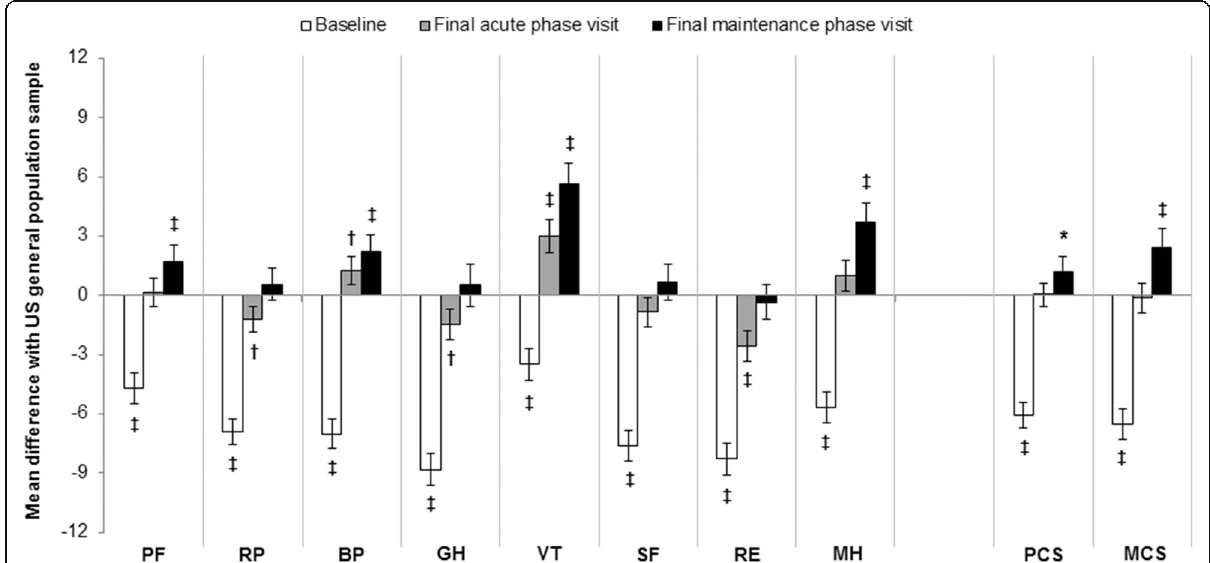
Fig. 2 SF-12v2 score differences between trial patients and an age- and gender-matched US general population sample. PF: physical functioning; RP: role physical; BP: bodily pain; GH: general health; VT: vitality; SF: social functioning; RE: role emotional; MH: mental health; PCS: physical component summary; MCS: mental component summary. Error bars reflect 95% confidence intervals around mean differences. Significantly different from